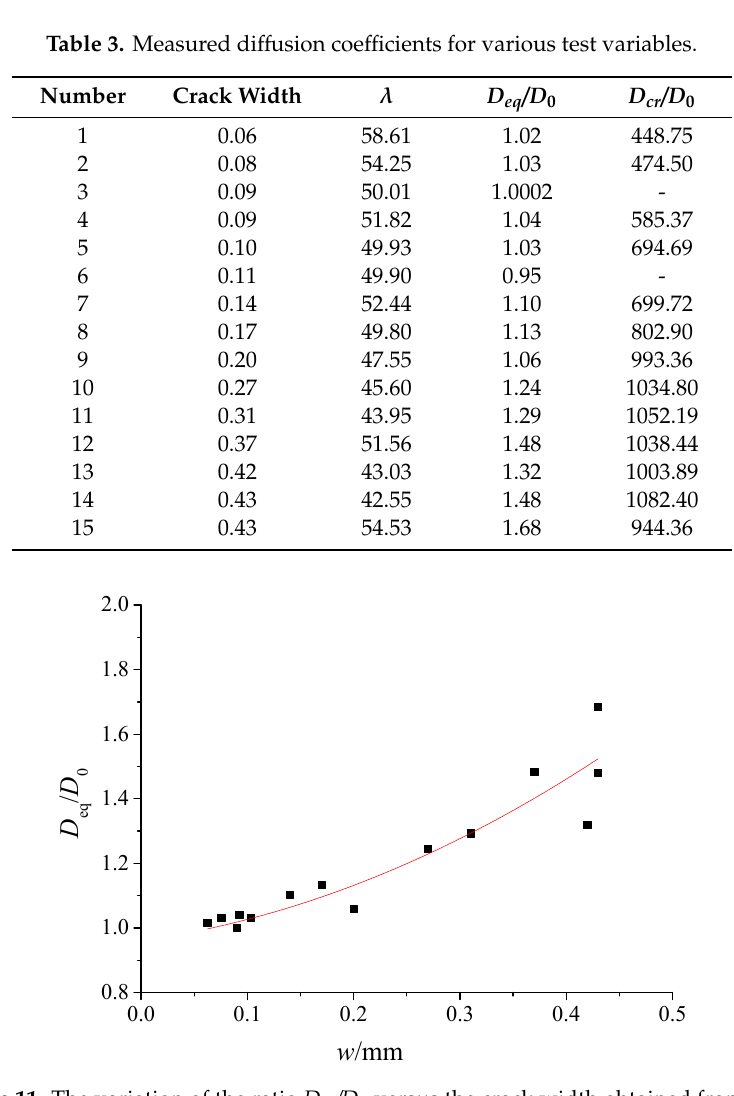
Figure 11. The variation of the ratio D eq / D 0 versus the crack width obtained from tests.